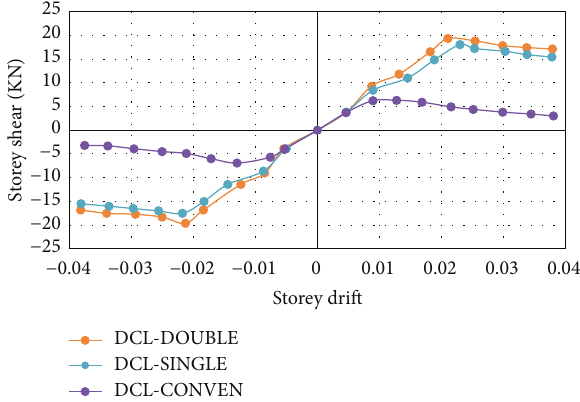
Figure17:Envelopcurvesforcomparingthemaximumloadineach cycle for the DCL